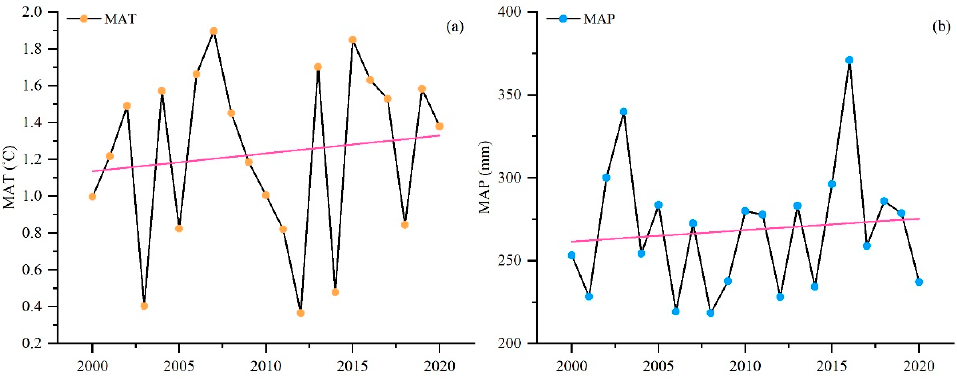
Figure 10. The variations in average temperature ( a ) and precipitation ( b ) in the Tianshan Mountains from 2000 to 2020.